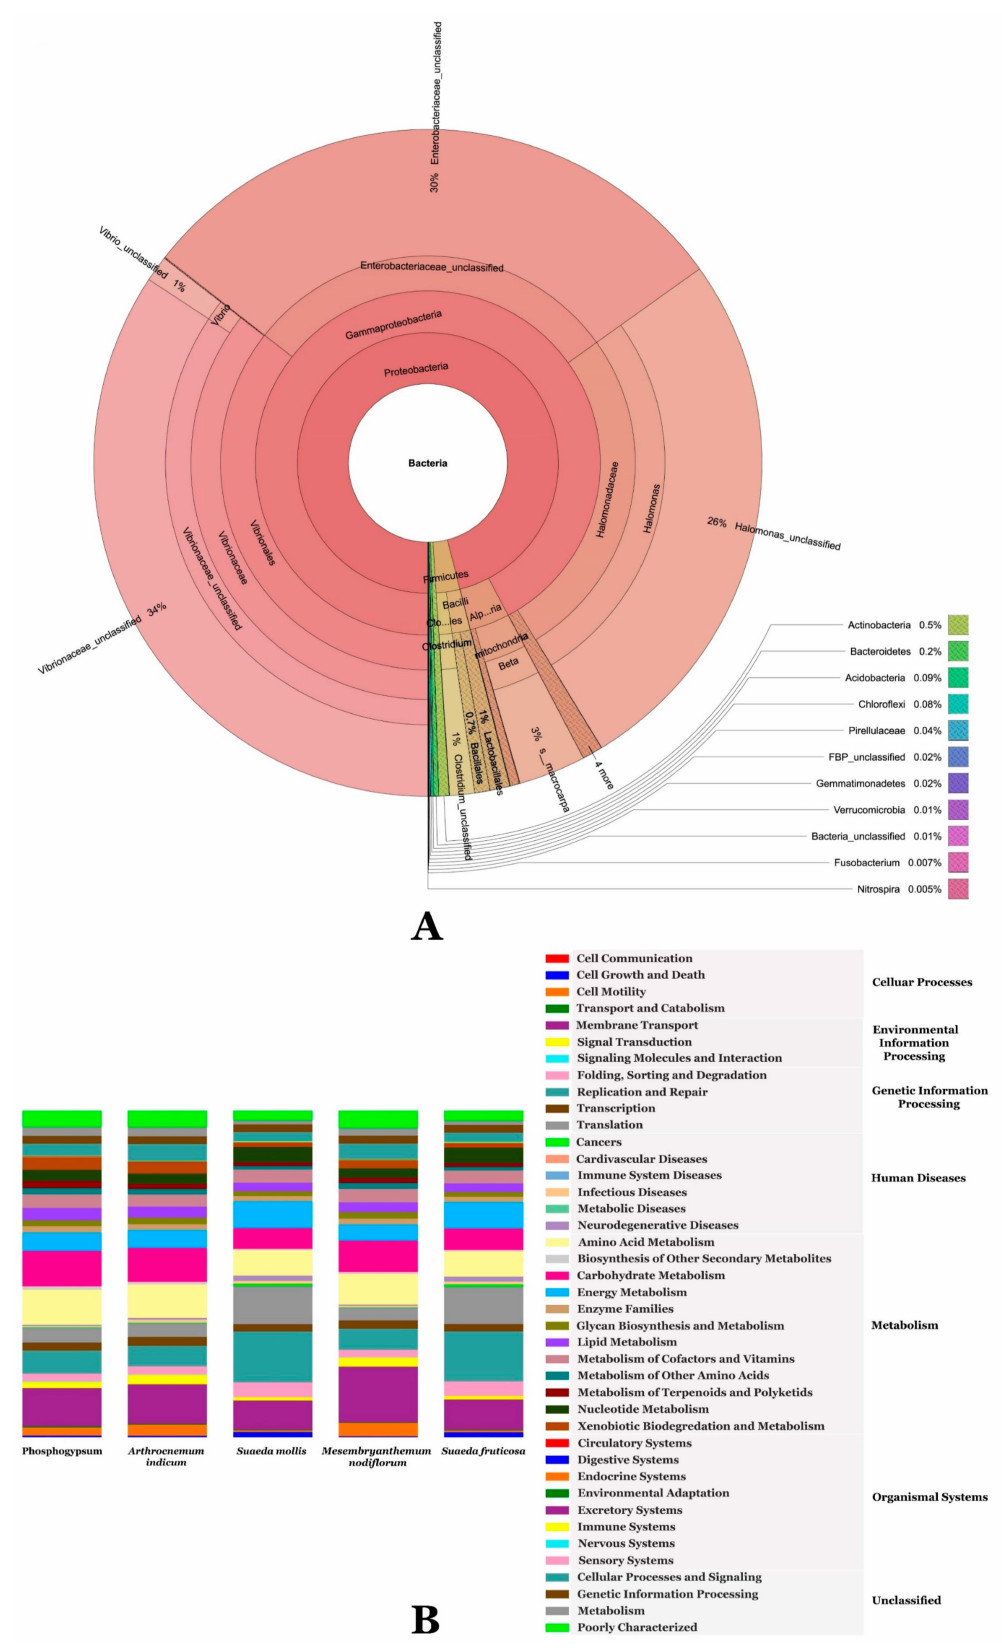
Figure 5. Krona chart ( A ) and PICRUSt classification of KEGG Orthologies (KO) ( B ) of phosphogypsum and plant microbiomes generated using